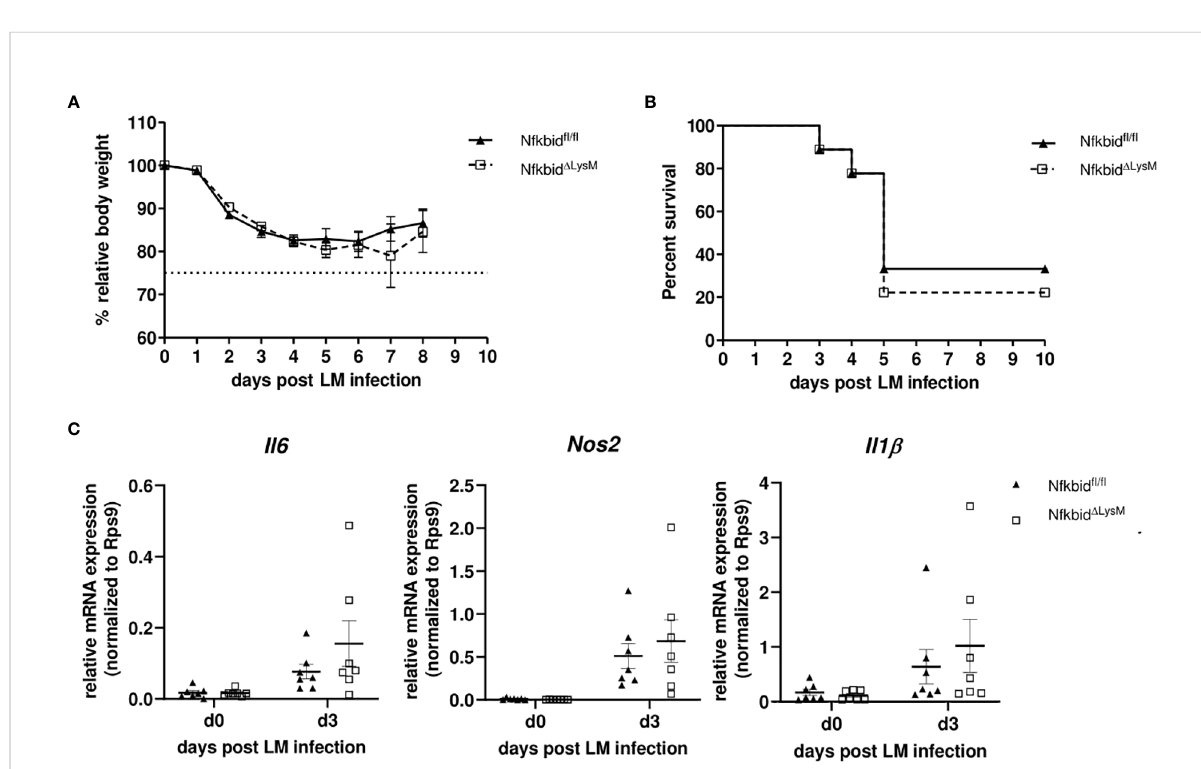
FIGURE 6 Infection of conditional knock-out mice harboring a speci fi c deletion of I k B NS in macrophages and granulocytes with Listeria monocytogenes . (A) Body weight loss depicted as percent of initial body weight and shown as mean ± SEM. Data are pooled from three independent experiments (Nfkbid fl / fl littermates ( ▲ , n=9), Nfkbid D LysM ( □ , n=9). (B) Kaplan-Meier plot for survival following LM infection. (C) Relative mRNA expression levels of pro-in fl ammatory cytokines ( Il6, Nos2, Il1b ) from sorted in fl ammatory monocytes from liver samples of Nfkbid D LysM mice and Nfkbid fl / fl littermate controls. Represented is the mean ± SEM from 7 mice per group and point in time from two independent performed